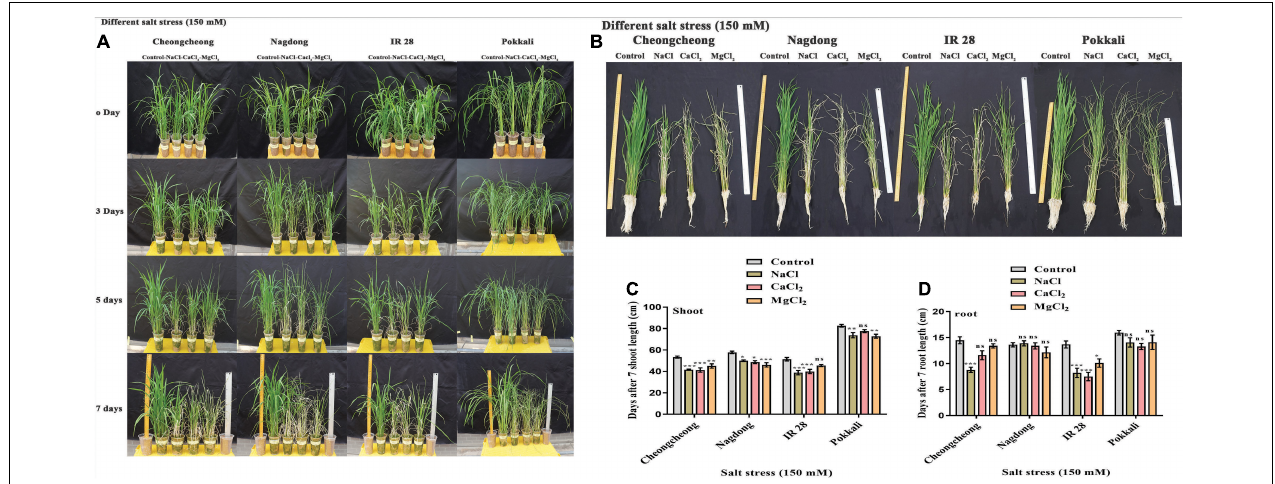
FIGURE 2 | Phenotypic evaluation of rice genotypes under 150 mM of different salts (NaCl, CaCl 2 , and MgCl 2 ) in a greenhouse. (A) Effects of different salts after 0, 3, 5, and 7 days. (B) Measurement of the growth index of each rice cultivar. (C,D) Shoot and root length determination. Statistical analysis was calculated by the Bonferroni posttest two-way repeated-measures analysis of variance. Asterisks in the vertical bar indicate a significant difference at * p < 0.05, ** p < 0.01, *** p < 0.00, compared to